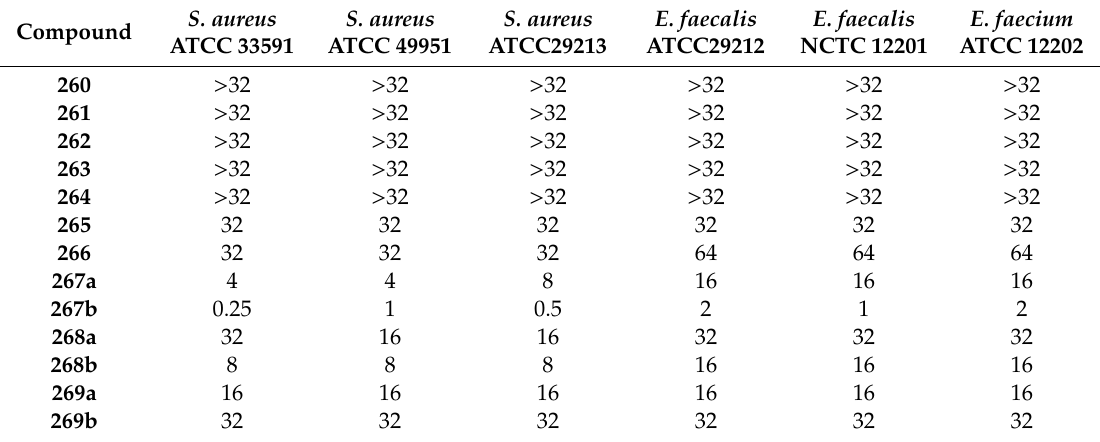
Table 34. Inhibitory e ff ects of compounds 260 – 269b against Staphylococcus aureus ATCC 33591 (methicillin-resistant), Staphylococcus aureus ATCC 49951, Staphylococcus aureus ATCC29213,